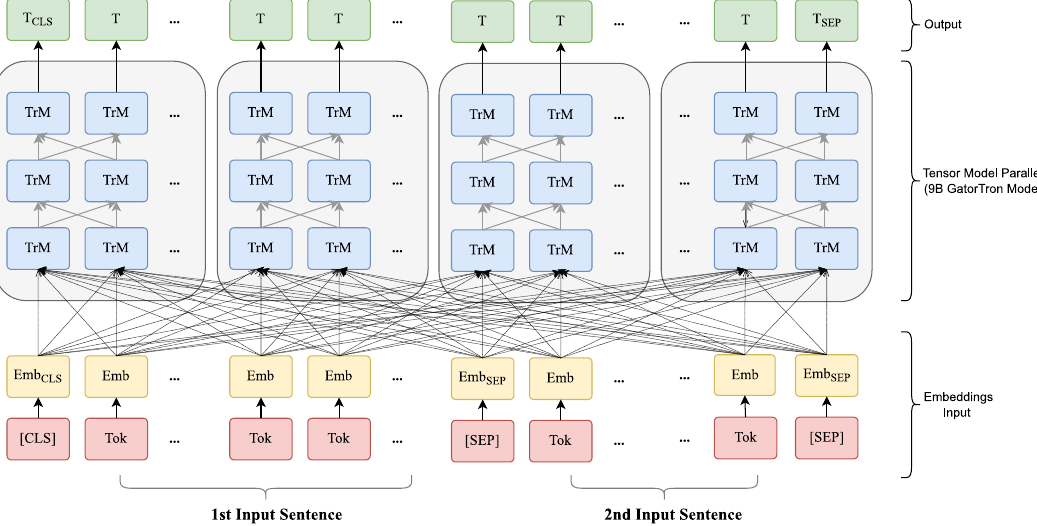
Fig. 4 Pretraining GatorTron-large model with 9 billion parameters using model parallelism. Emb embedding, Tok Token from input sentence, Trm Transformer unit. [SEP]: a token de fi ned in BERT to indicate sentence boundaries. [CLS]: a token de fi ned in BERT for sentence- level